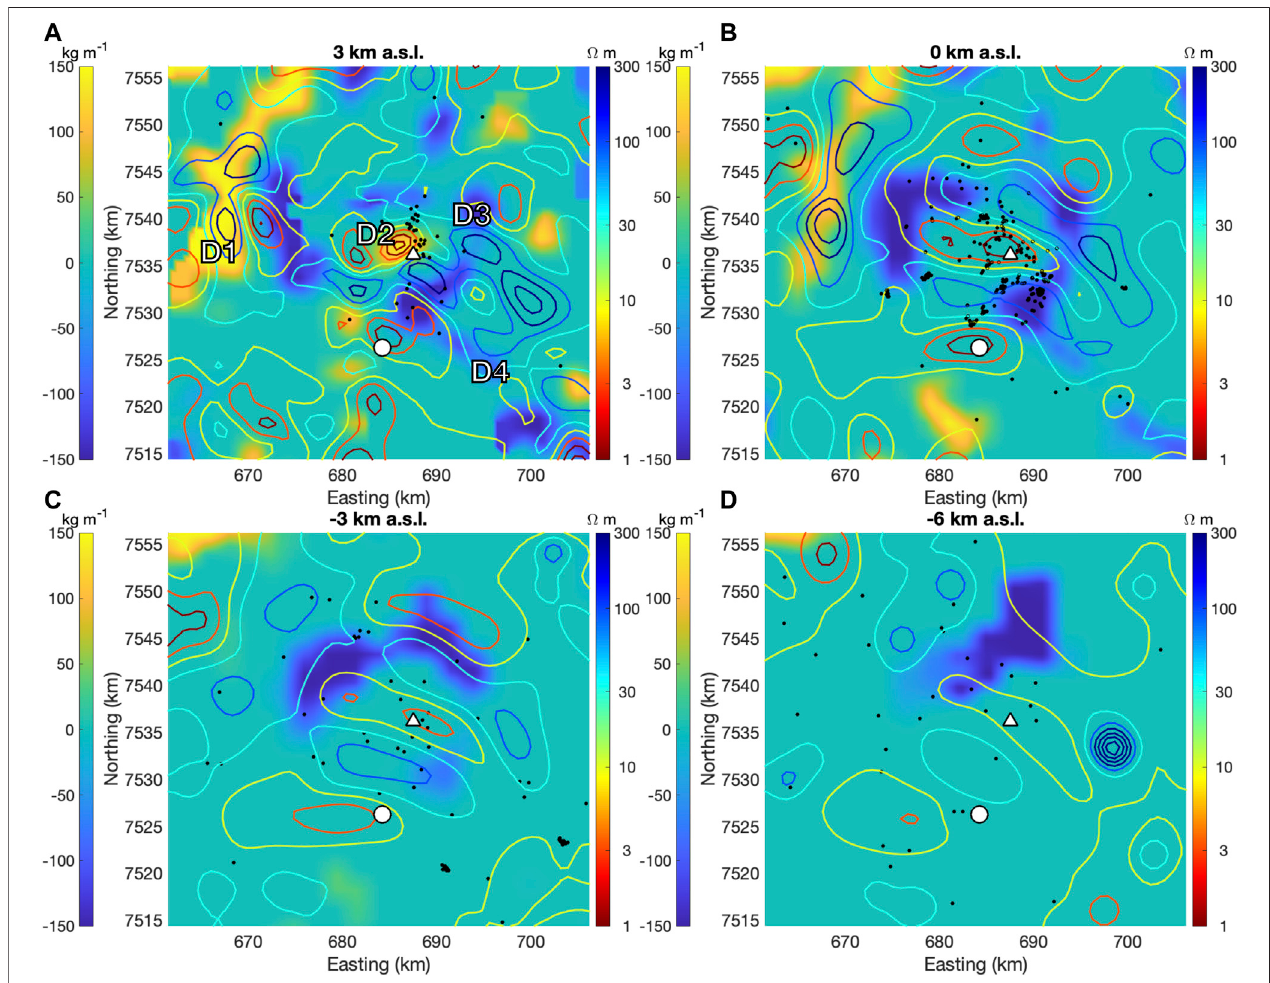
FIGURE 8 | Overlay of resistivity model (colored contours) on density model, using same depth slice as in Figure 5 . Relocated earthquake hypocenters from previous seismic deployments (Jay et al., 2012; Kukarina et al., 2017; Hudson et al., 2021) within 500 m ofthe depth slice elevation plotted as black dots. White triangle marks the location of the peak of Uturuncu, and the white circle marks the location of the small subsidence area imaged in Lau et al. (2018) and Eiden et al. (2020).